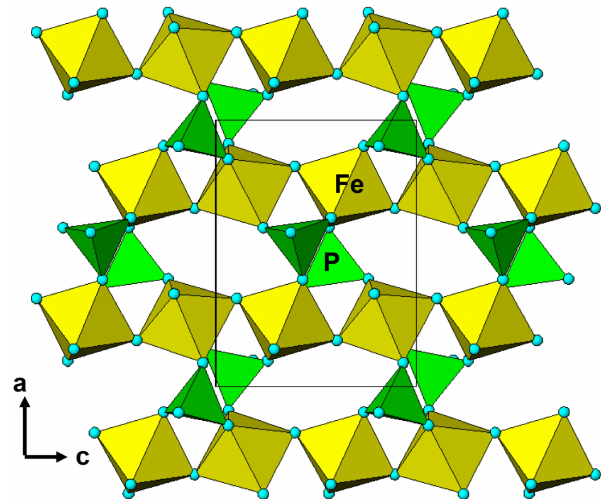
Figure 9. A (010) slice of the allanpringite crystal structure, equiv- alent to a (100) slice of the strunzite crystal structure, having the same corner-connected chains of Fe-centred octahedra intercon- nected via corner sharing with PO 4